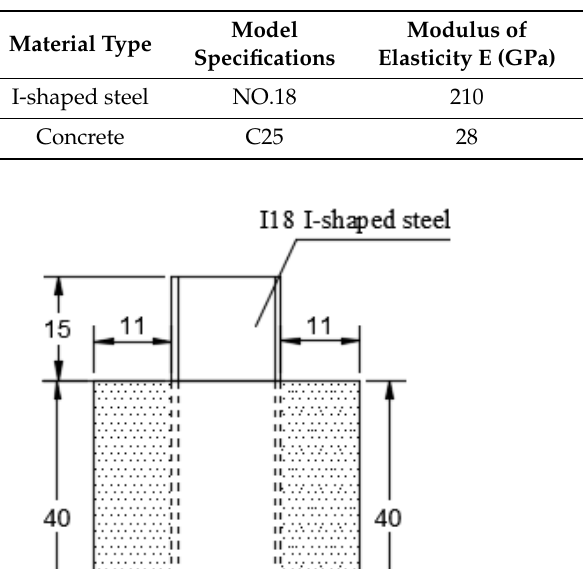
Table 1. The parameters of I-shaped steel and concrete.